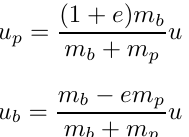
Fig. 11. Comparison of measured pressure on the base of device A (obtained from the Hopkinson bar test) with numerical prediction. experimental results with a numerical model, a double-collisions model is used to calculate the impulse delivered to the blast wave mitigation device from the pendulum ball. The first collision between the pendulum ball and the device is partially inelastic. The velocities of the piston and the pendulum ball after the collision are